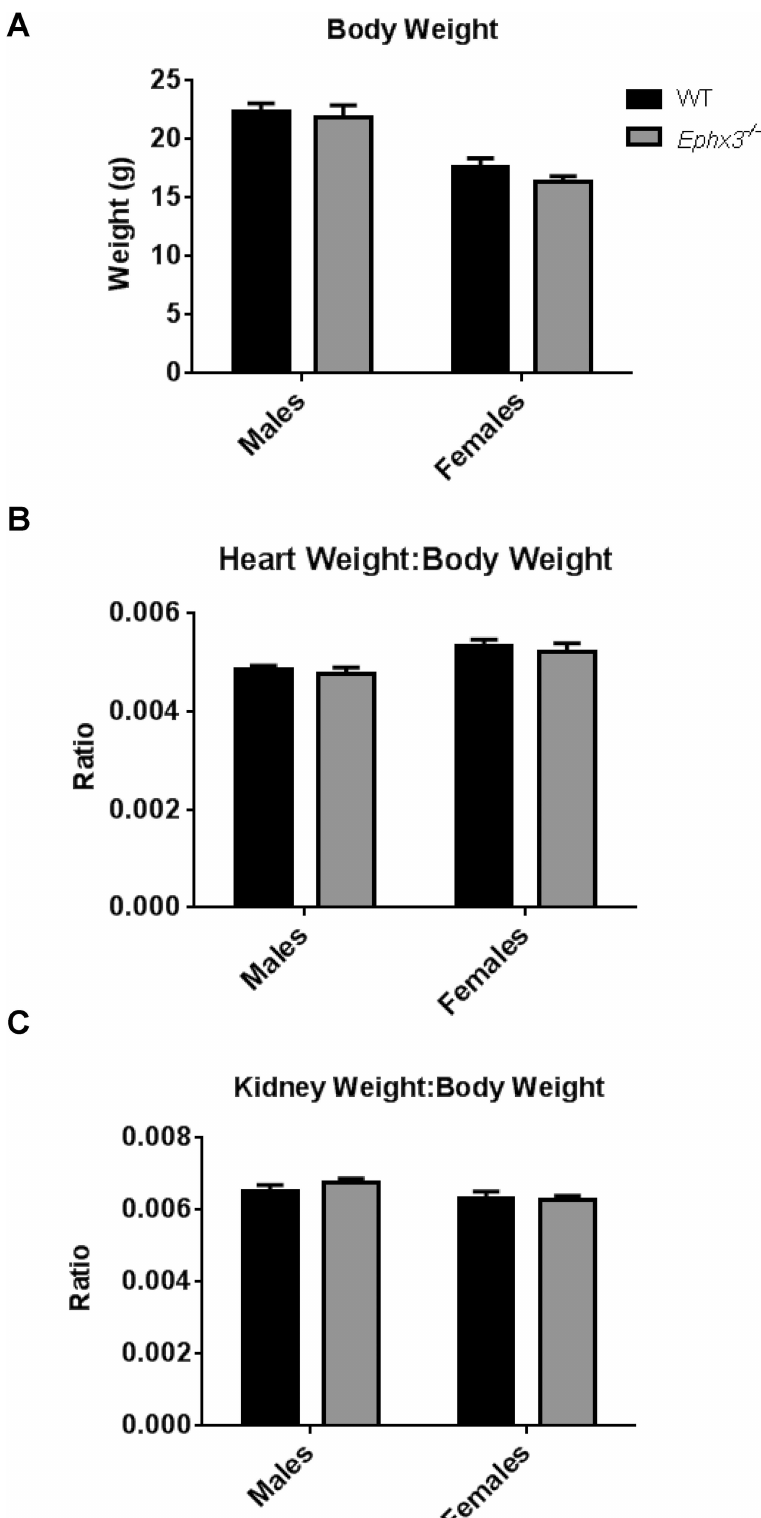
Fig 4. Body weight and organ weight:body weight ratios are not altered in Ephx3 -/- mice . (A) Body weight of both male and female WT and Ephx3 -/- mice. (B) Heart weight:body weight ratio and (C) kidney weight:body weight ratio in Ephx3 -/- and WT mice (n = 5–10, p = NS). https://doi.org/10.1371/journal.pone.0175348.g004 PLOS ONE | https://doi.org/10.1371/journal.pone.0175348 April 6,